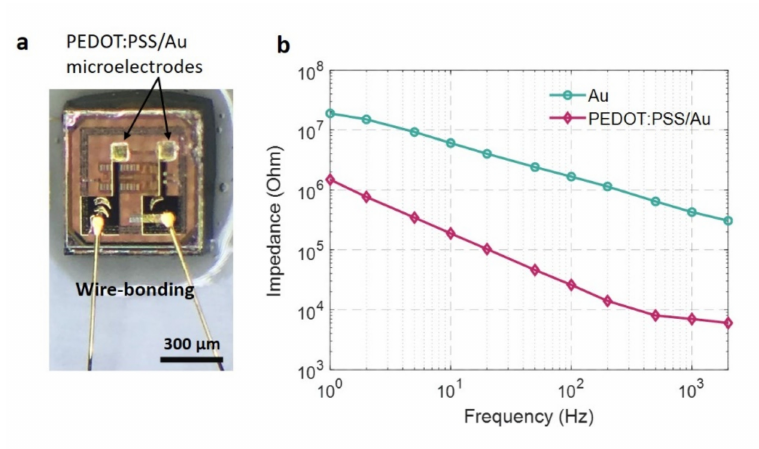
Figure 7. ( a ) An optical image of 70 µ m square PEDOT:PSS coated Au microelectrodes. The elongated Au traces are connected to the wired external tester. The entire assembly is encapsulated with epoxy resin except for the electrode sites; ( b ) Impedance spectra comparing PEDOT:PSS coated Au and the uncoated Au microelectrodes of the same